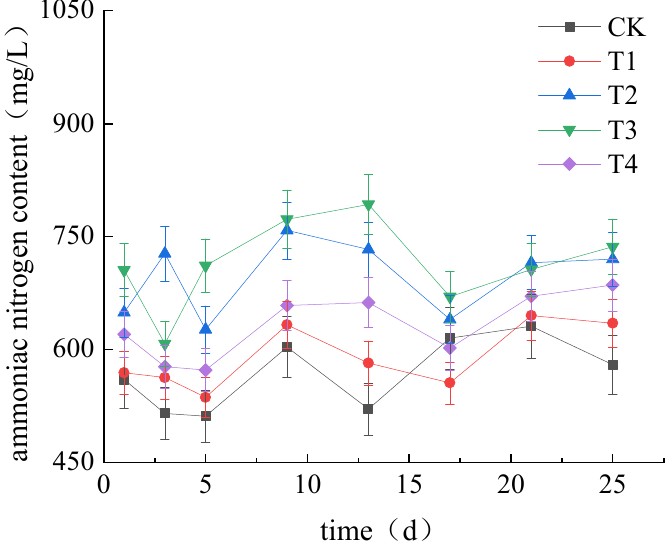
Figure 7. Effect of supernatant reflux of biogas slurry on ammonia nitrogen.